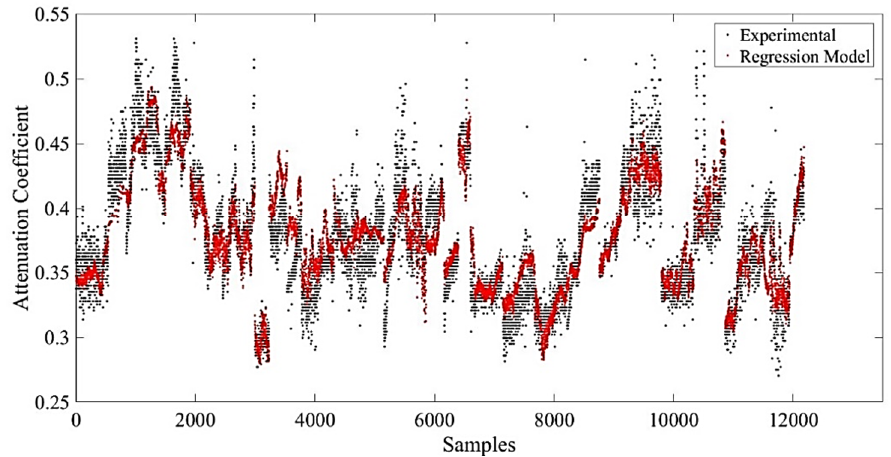
Figure 2. Experimental and regression model of Equation (6) results.